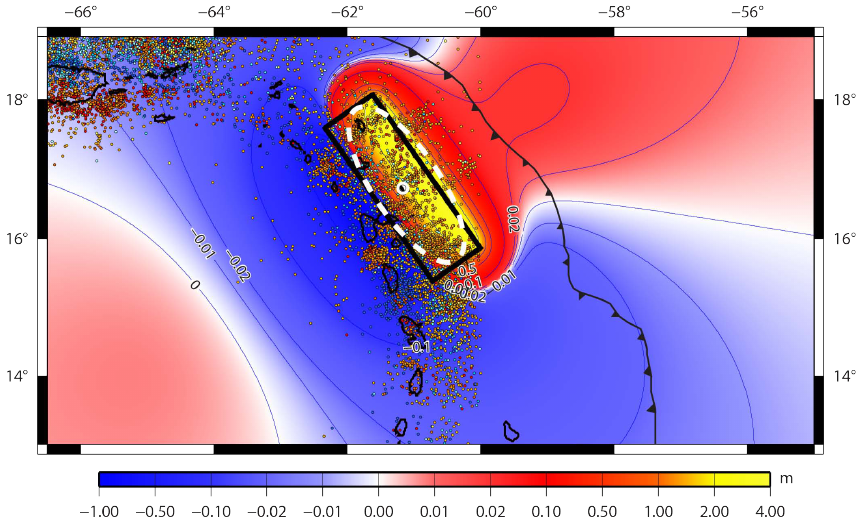
Fig. 6. Initial coseismic deformation of the seafloor computed for a 1843-like event. The black rectangle symbolizes location of the rupture plane superimposed with the rupture area proposed by Feuillet et al. (2011) symbolized with a white dashed ellipse. The subduction trench (black line) and local seismicity from USGS-NEIC (1973 to present) are also indicated.